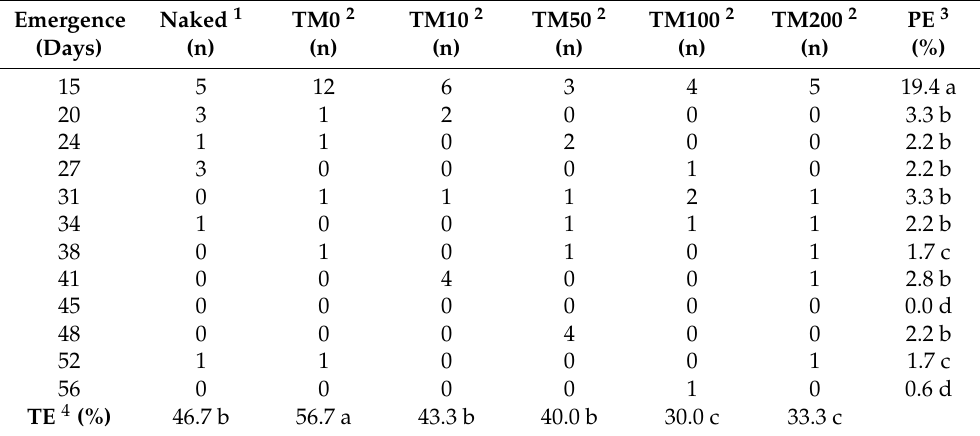
Table 2. Above-ground parameters monitored at the end of the experiment. Naked 1 2.7 a TM0 2